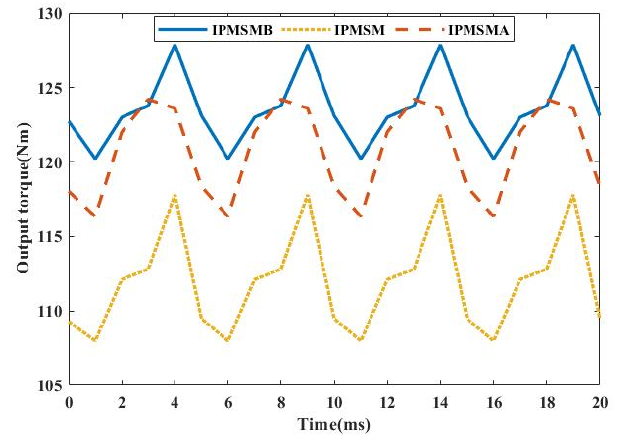
Figure 13. Output torque of three types of motors.